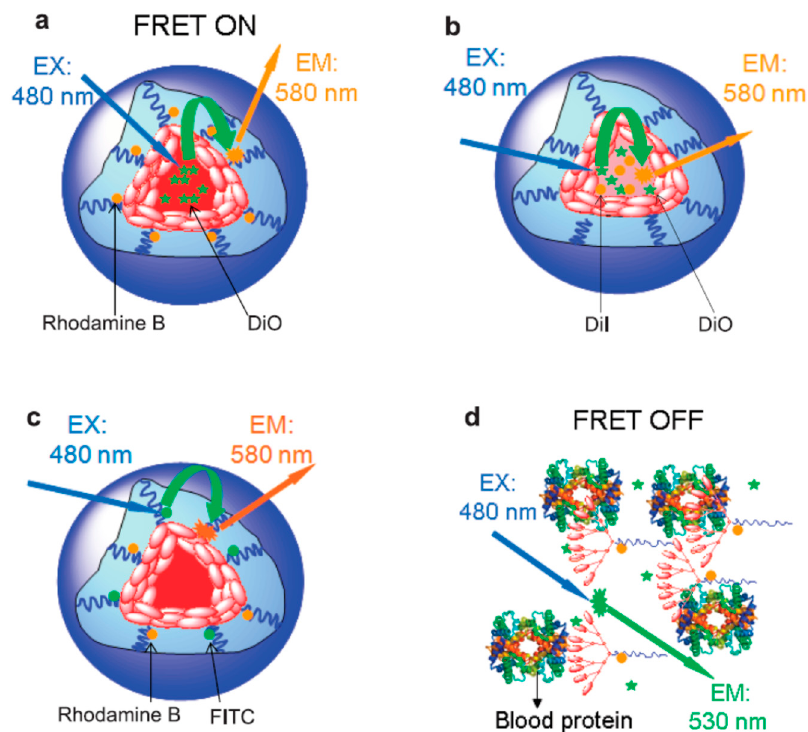
Figure 14. Schematic of non-cross-linked FRET-based NPs FRET-NCMN1 (DiO and rhodamine B pair) ( a ), FRET-NCMN2 (DiO and DiI pair) ( b ), FRET-NCMN3 (FITC and rhodamine B pair) in PBS ( c ), and FRET-NCMN1(DiO and rhodamine B pair) in human plasma ( d ). Reproduced with permission from ref. [32]. Copyright 2012, American Chemical Society.